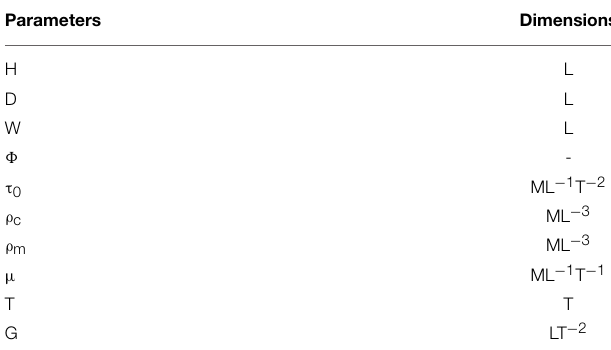
TABLE 1 | The 10 principal parameters of the idealized example (Figure 1) are expressed in three dimensions only, which are length [L], mass [M], and time